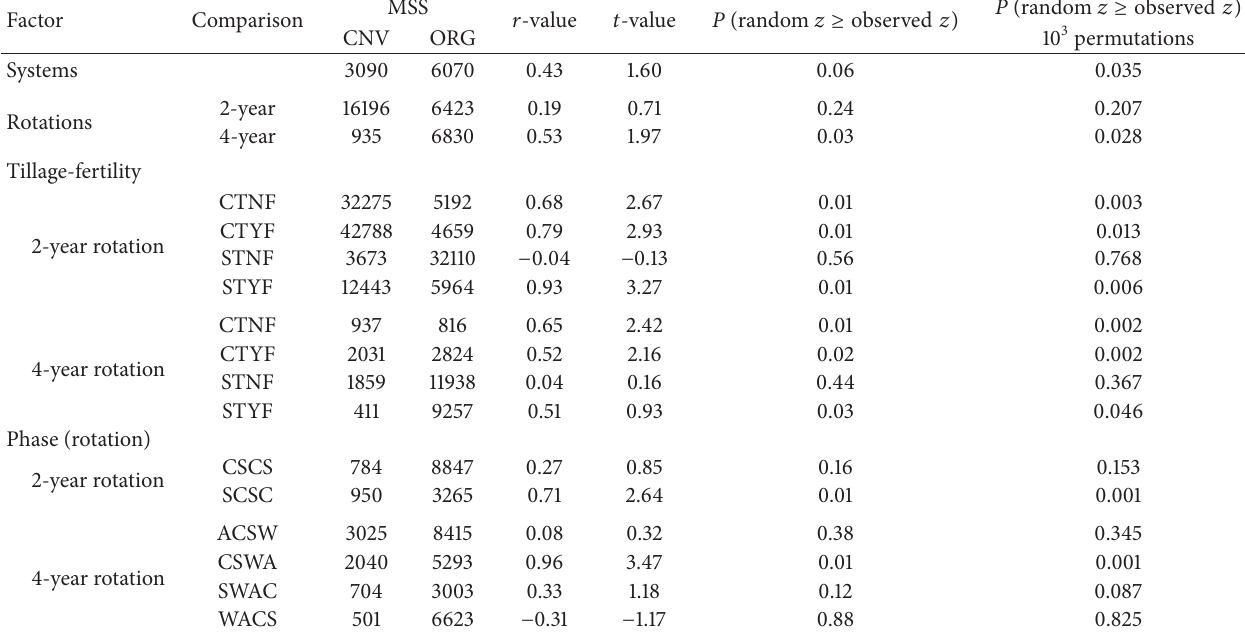
Table 6: Conventional (CNV) and organic (ORG) cropping systems pairwise dissimilarity (covariance) matrix correlation statistics based on whole systems, crop rotations, tillage-fertility treatments within 2-year and 4-year crop rotations, and phases within 2-year and 4-year crop rotations. Covariance matrices were derived from cumulative yield, temporal yield variance, and coefficient of variation of two rotation cycles in a long-term field